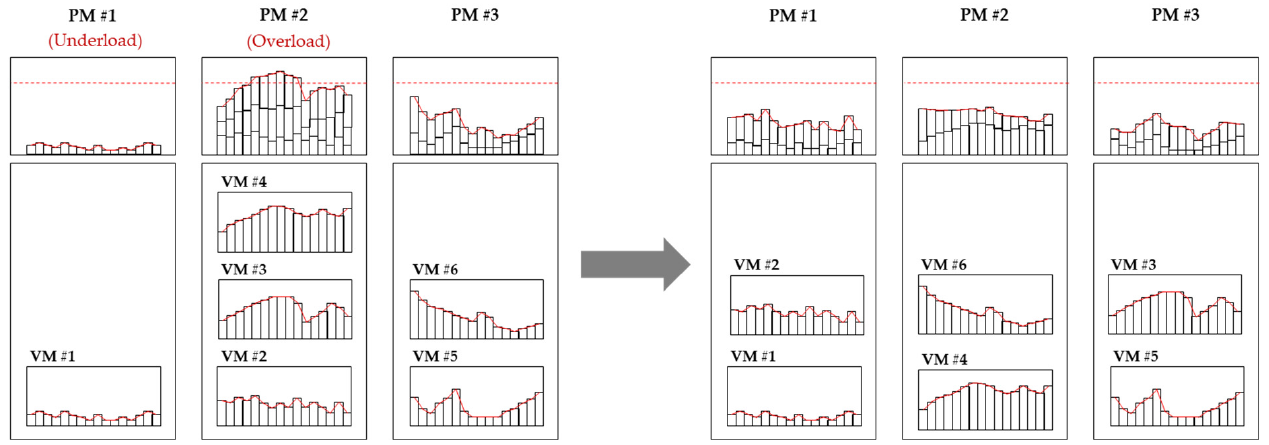
Figure 6. VM consolidation with stable PM workload.